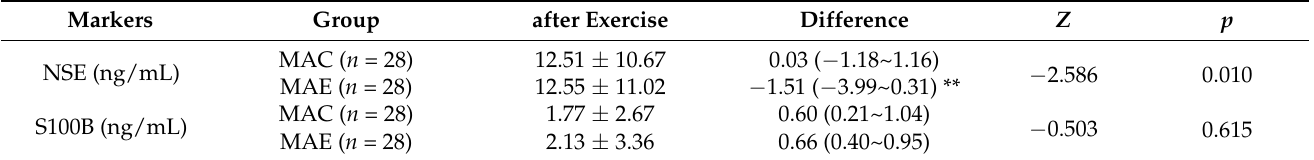
Table 3. Amount of change in serum NSE and S100b levels and MAC and MAE groups after exercise intervention.